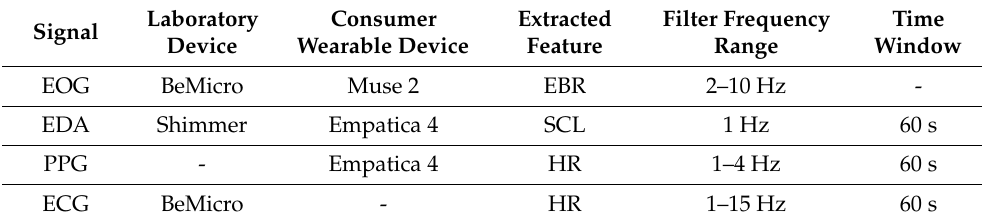
Table 1. A summary of the devices and signals used in the presented